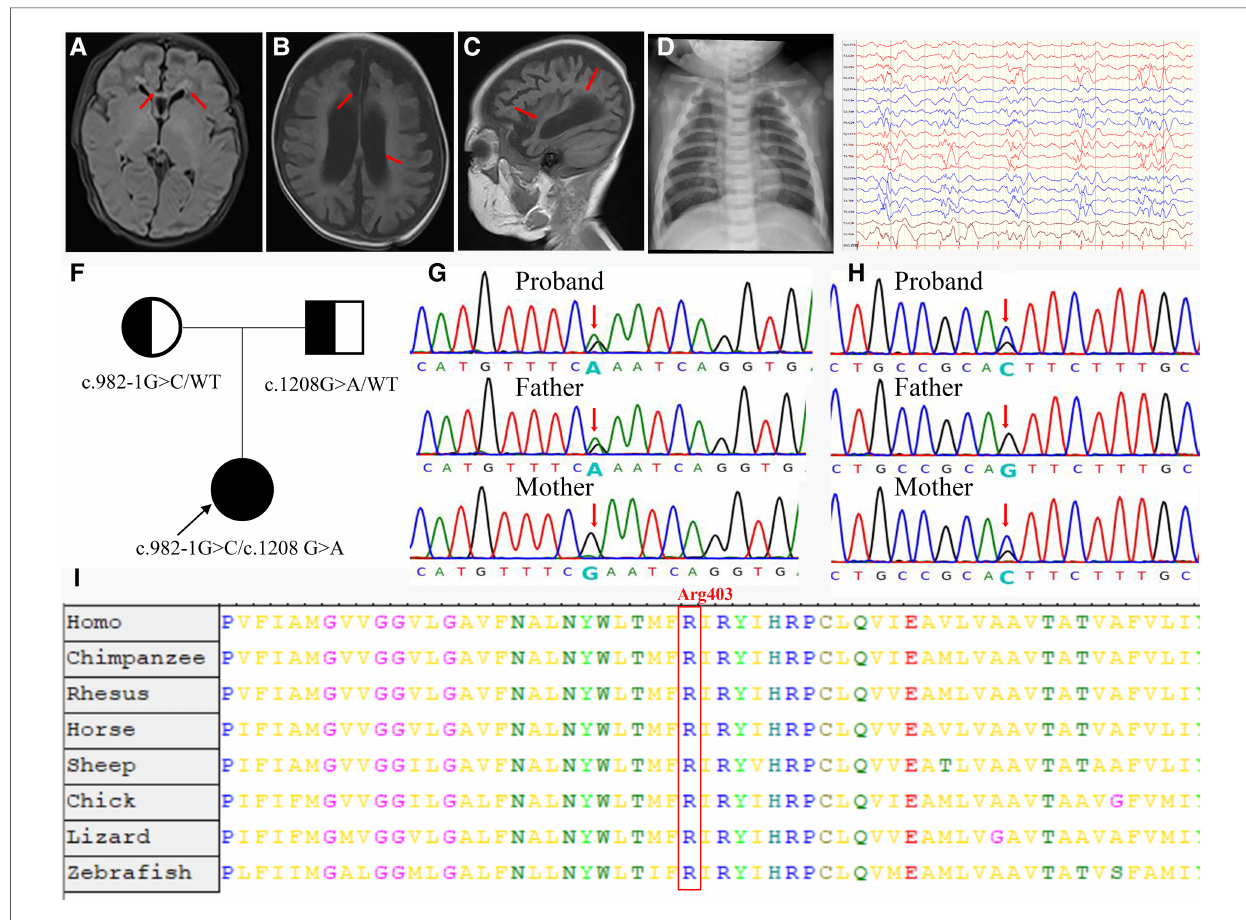
FIGURE 2 Clinical and molecular fi ndings of the patient. ( A ) T1-weighted (T1W) brain MRI indicated a high signal in the white matter (arrowheads) and corpus callosum (arrowheads) during the neonatal period. ( B,C ) T1W brain MRI indicated hydrocephaly (arrowheads) and brain atrophy (arrowheads) at 4 months of age. ( D ) Proband showed increased bone density on radiography and “ sandwich ” vertebrae. ( E ) Multifocal slow spike-wave and slow-wave patterns in electroencephalogram. ( F ) The proband ’ s family tree. ( G ) The proband was paternally inherited the variant of c.1208G>A in the CLCN7 gene. ( H ) The proband was maternally inherited the variant of c.982-1G>C in the CLCN7 gene. ( I ) A cross-species alignment of amino acid sequences showed that p . Arg403Gln variants were located in a highly conserved region in CLCN7 protein.